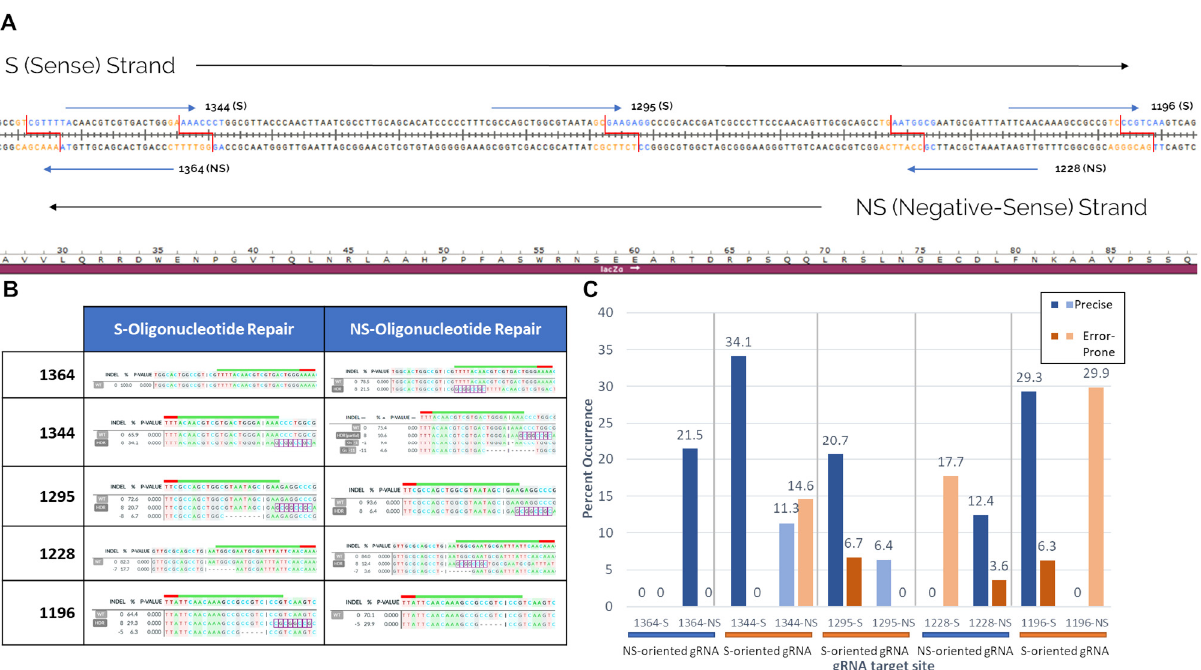
Figure 3. Secondary non-ExACT products seen in ssODN-containing reactions. ( A ) Schematic of the LacZ site tested in the in vitro system. Five total sites were analyzed (blue arrows represent gRNA), with the cleavage sites highlighted with red lines. Each cut site was repaired with one of two symmetric ssODNs identical to the sense or negative-sense strand, containing an 8 bp insertion directly at the specific cut site. The bases in yellow and the bases in blue represent the DNA ends resulting from each gRNA cut upstream and downstream, respectively. ( B ) Resultant repair outcomes for each site, with each ssODN utilized at that site. Deconvolution and alignment of Sanger sequencing products of each in vitro product are displayed, with inserted bases highlighted with purple boxes and deleted bases shown as dashes. Relative percentages of each product are also shown. ( C ) Quantification of non-HDR indel percentages. For each of the five cleavage sites, the rates of precise (ExACT-driven) and error-prone (MMEJ/NHEJ-driven) products are shown in blue and orange, respectively. For reactions that contained gRNAs and oligos in the same orientation, darker colors are used, while reactions that used gRNAs and oligos of the opposite orientation are displayed with lighter colors.